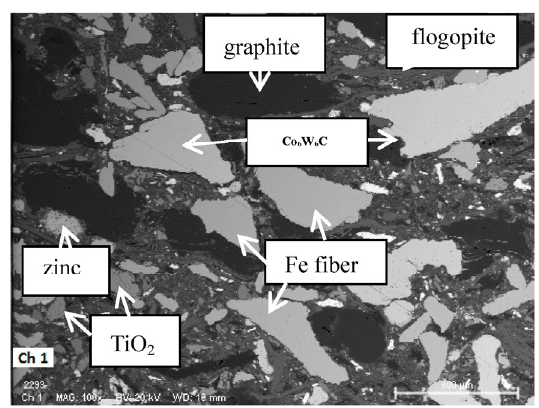
Fig. 1 SEM micrographs showing the microstructure of the FM4 pad